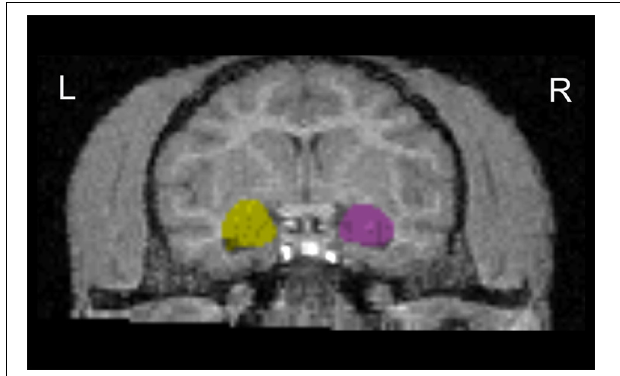
FIGURE 2 | Coronal view of the amygdala outline in T1-weighted images. Images were aligned to the hippocampus axis. L, left hemisphere; R, right